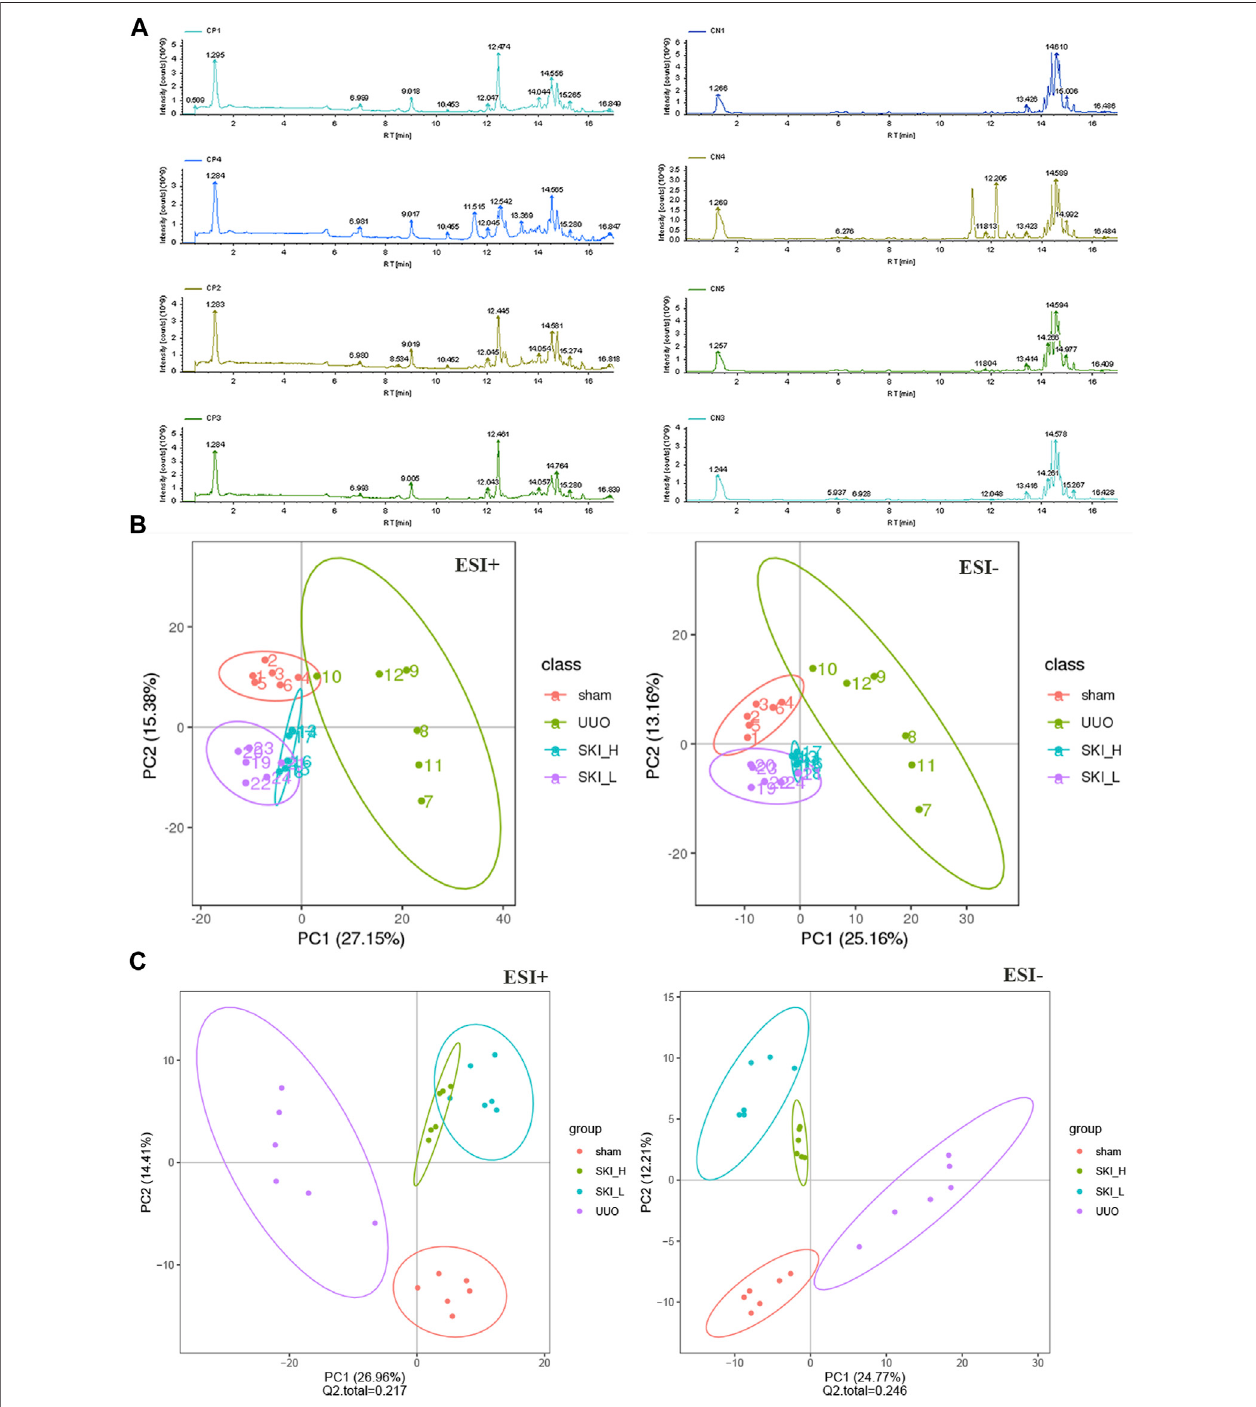
FIGURE 13 | PCA and PLS-DA scores of metabolic differences in Sham, UUO, and SKI group. (A) The representative BPI chromatograms (ESI+) of metabolomic samples. (B) PCA scores of mice in each group. (C) PLS-DA scores of mice in each group. Red dots for Sham; Purple dots for UUO; Blue and green dots for SKI.